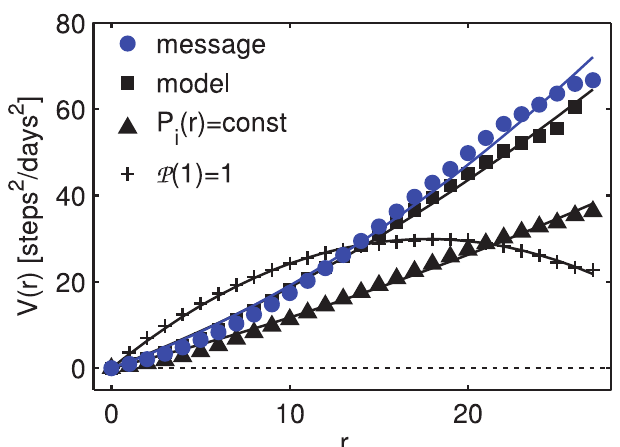
Fig 7. Interaction potential derived from the random walker model. The interaction potential derived from the random walker model (squares) reproduces to a large extent the empirical potential for messages (blue circles). The model uses the actual topology of the universe and assumes an attractive acceleration that is conditional on interaction but independent of the distance. Triangles show the situation where the distance- dependent interaction probabilities are set to be constant, (+) represent an unrealistic constant jump-distance distribution of one step per time. Lines are least-squares fits to harmonic potentials as in Eq